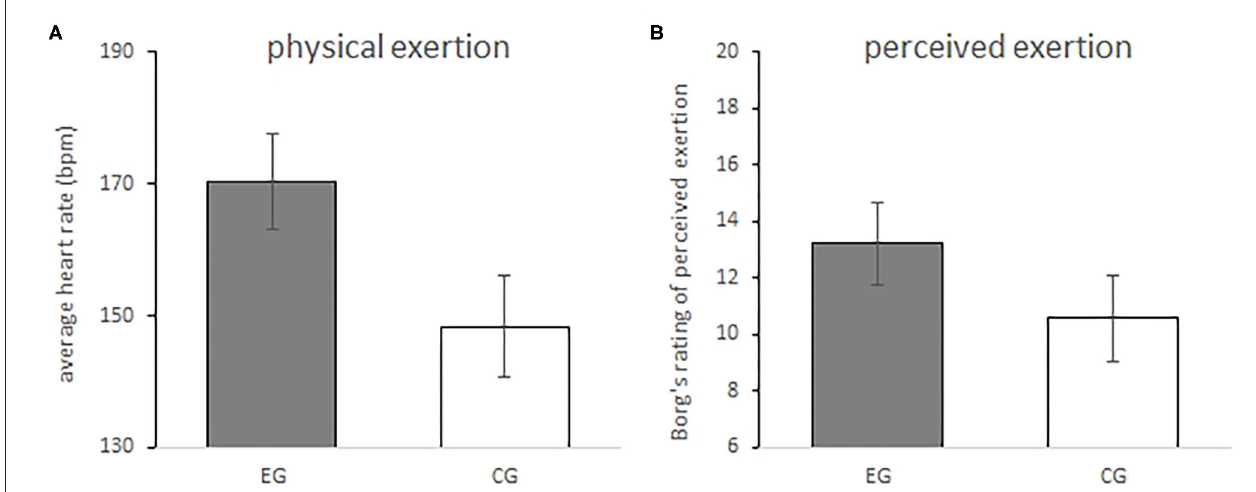
FIGURE 2 | Physical (A) and perceived exertion (B) during the 30min run in comparison between the experimental (EG, gray bar) and the control group (CG, white bar). Actual physical exertion during running (i.e., averaged over the 30min run) was measured using heart rate monitors, with higher beats per minute (bpm) indicating higher physical exertion. For perceived exertion students were asked to self-report how hard they had to push during running using Borg’s rating of perceived exertion (RPE). Higher RPEs indicate higher exertion. Error bars indicate 95% CI.